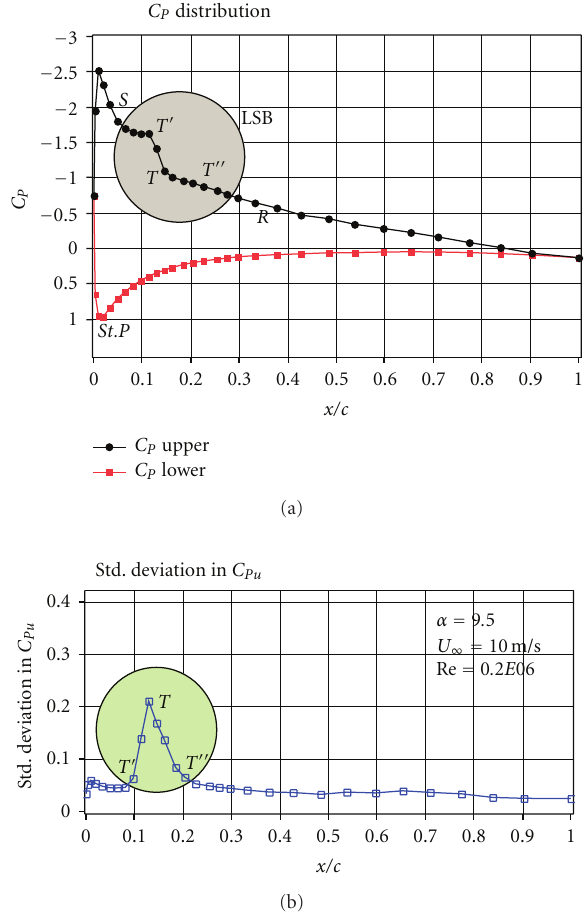
Figure 7: C P distribution and its standard deviation at Re = 0 . 2 E 06 and α = 9 . 5 ◦